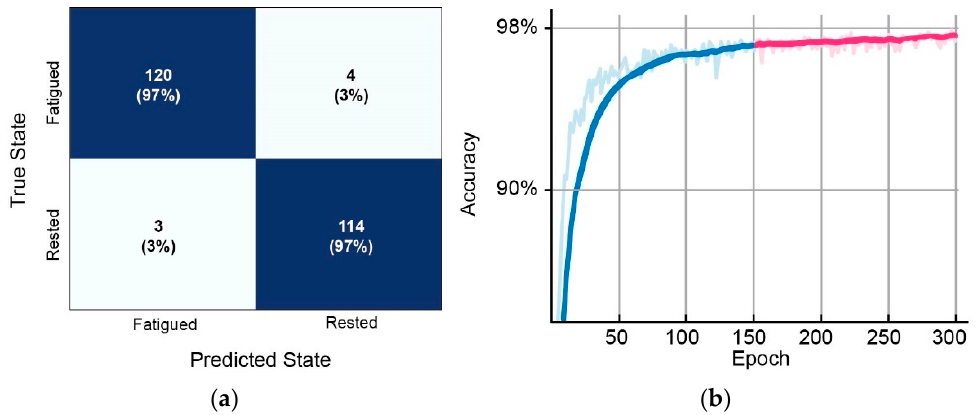
Figure 3. ( a ) Proposed model confusion matrix; ( b ) validation curve for 150 epochs (blue) and 300 epochs (magenta). Darker colors represent a smoother